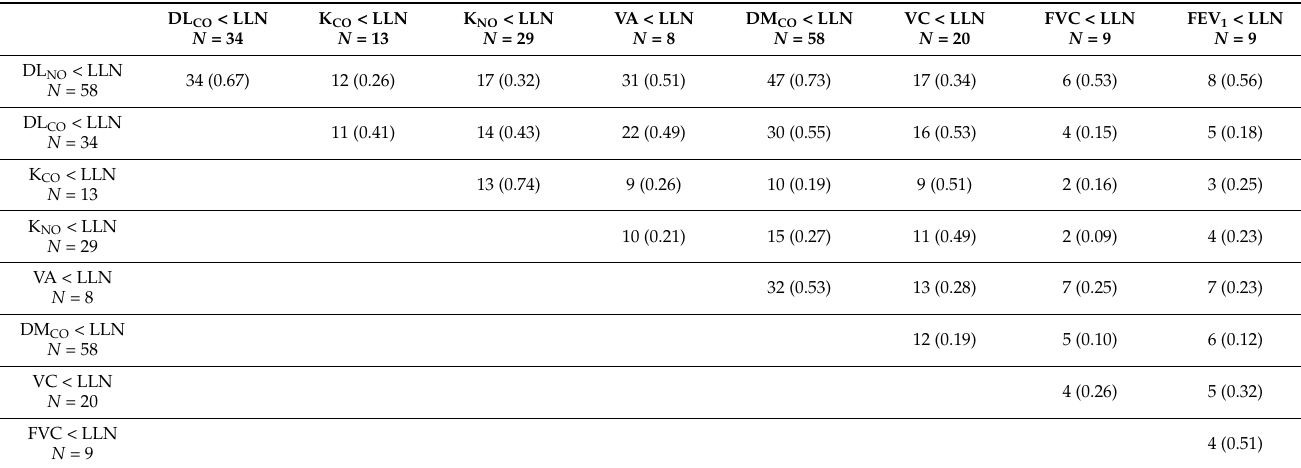
Table 3. Concordance between the alteration between the different functional tests performed, including the coincident number and the kappa coefficient (in